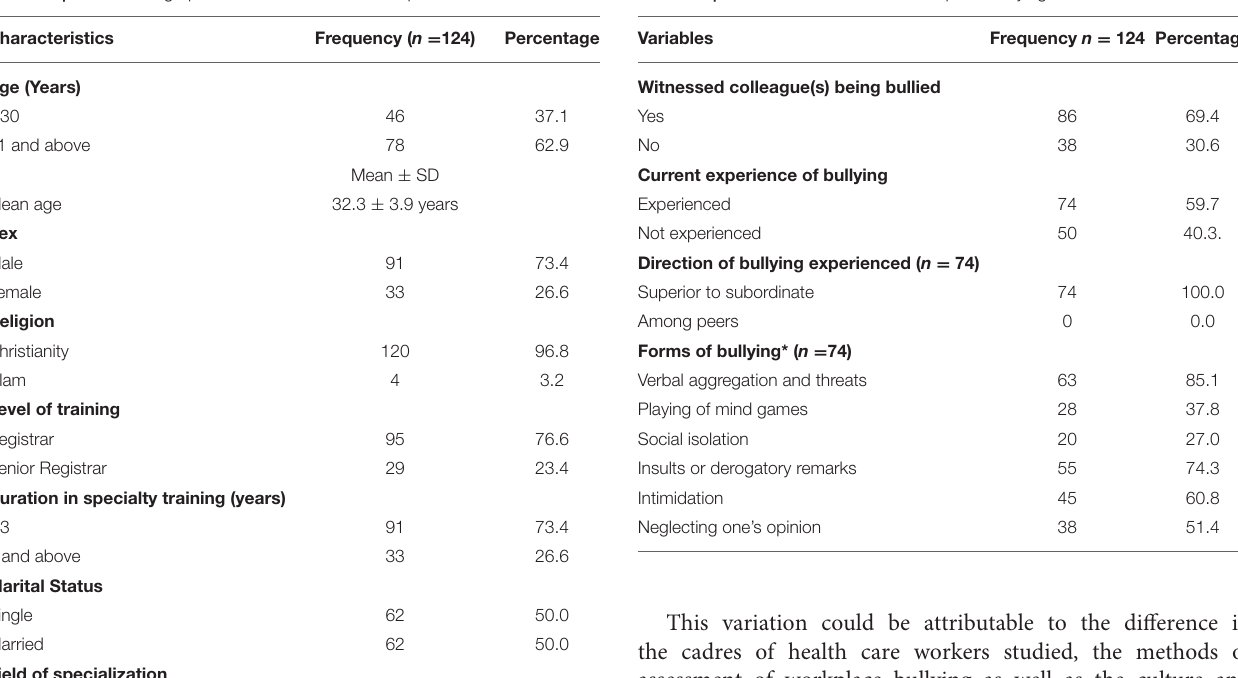
TABLE 1 | Socio-demographic characteristics of the respondents. TABLE 2 | Prevalence and forms of workplace